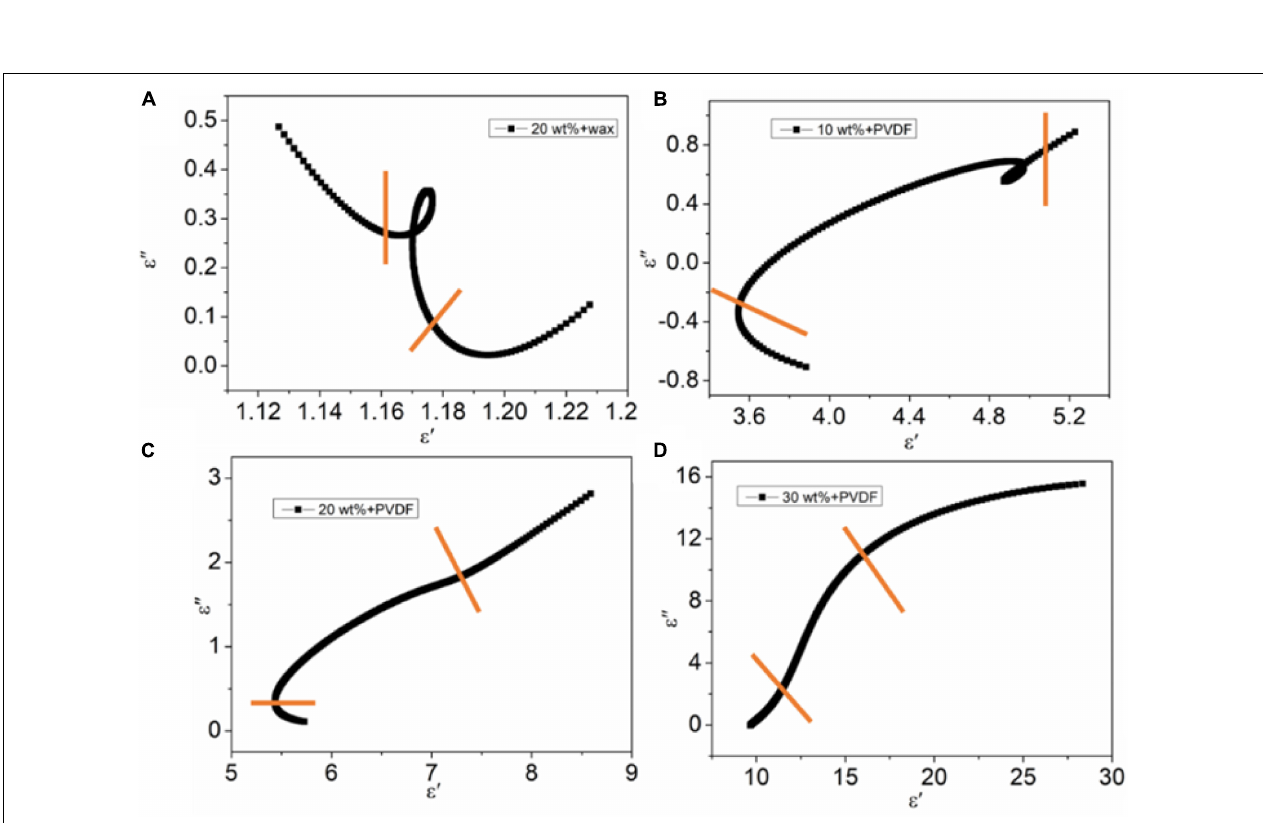
FIGURE 7 | (A) ε ’ - ε " curve of Ni x S y /wax composite with a filler content of 20 wt%; filler content is (B) 10 wt%; (C) 20 wt%; and (D) 30 wt% of the ε ’- ε " curve of Ni x S y /PVDF